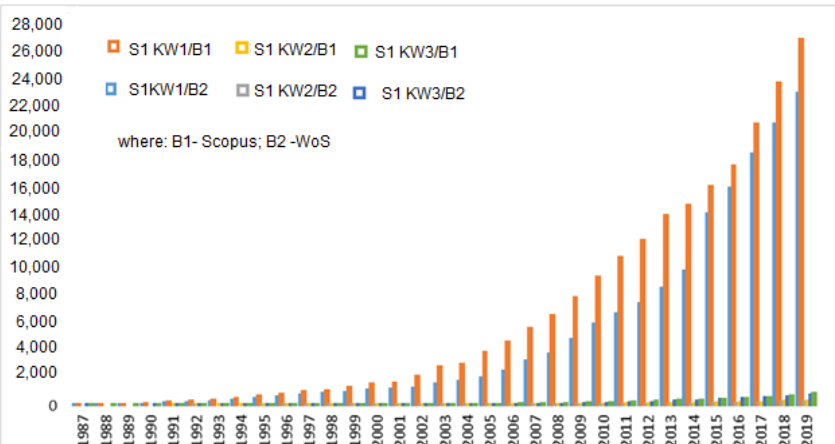
Figure 3. Number of scientific papers for particular keywords (KW) in the segment S1 “Sustainability”. Source: Own study based on the databases: Web of Science and Scopus. The dynamics of publications for keyword “Sustainability” in the period from 1987 to 2019 are shown in Figure 4.